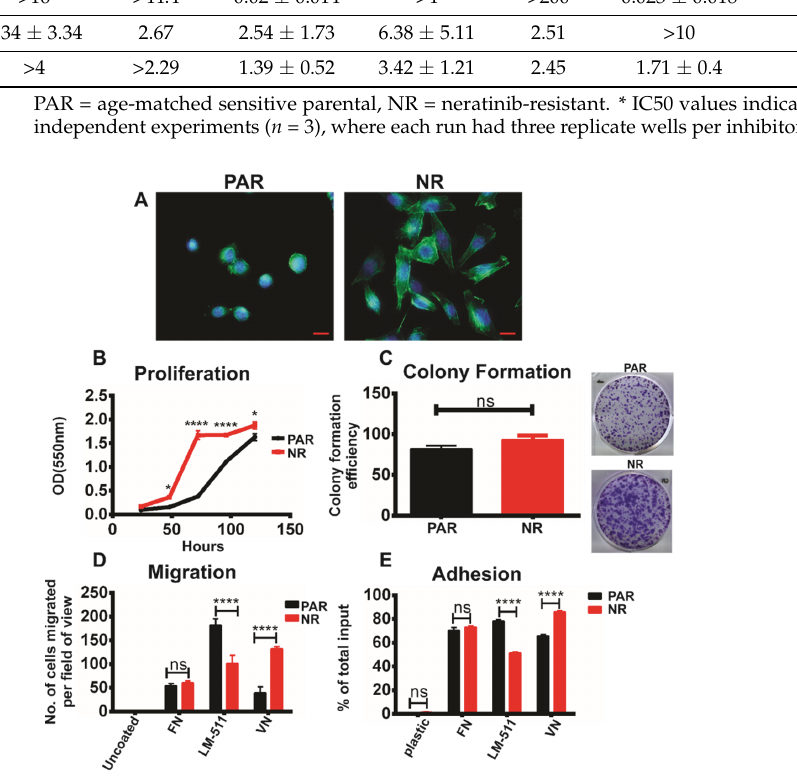
Figure 1. Morphological and functional characterisation of TKI-resistant cells in vitro. ( A ) The alterations in morphology and actin cytoskeleton were visualised in the resistant TBCP-1NR cells (NR) and compared to age-matched sensitive TBCP-1 cells (PAR) by F-actin staining using A488-conju- gated phalloidin. Red (Scale bar) = 50 µm. Blue (DAPI) = nuclei. Green (A488-phalloidin) = F-actin. ( B ) Cell proliferation was measured in TBCP-1 (PAR) or TBCP-1NR (NR) cells using a sulforhoda- mine B (SRB) colourimetric assay. Cells were seeded at 1000 cells/well in triplicates in 96-well plates and cultured over 5 days. Cell proliferation was measured at the indicated time points. Each point on the curve represents the mean ± SD of triplicates of the respective time point from a representa- tive experiment of three independent experiments ( n = 3). Statistical significance was determined using two-way ANOVA, Bonferroni’s multiple comparison test; p < 0.05 was considered significant, * p < 0.05, **** p < 0.0001. ( C ) Colony formation was measured in TBCP-1 (PAR) or TBCP-1NR (NR) cells over 10 days. Cells were seeded at 500 cells/well in a 6-well plate in triplicates and colonies were fixed with methanol and stained with crystal violet. Data show mean colony-formation effi- ciency (no. of colonies formed/total no. of cells plated × 100) ± SD of triplicates from a representative experiment of three independent experiments ( n = 3). Statistical significance was determined using the Mann–Whitney t -test; p < 0.05 was considered significant, ns = not significant. ( D ) Haptotactic migration of TBCP-1 (PAR) or TBCP-1NR (NR) cells in response to the indicated ECM proteins was evaluated in Transwell chambers and the number of migrating cells per field of view was deter- mined manually by counting DAPI-positive cells on the underside of the porous membrane. The data show mean ± SD of nine replicates (3 fields of view per membrane × triplicate membranes per condition) from a representative experiment of three independent experiments ( n = 3). ( E ) The ability of TBCP-1 (PAR) or TBCP-1NR (NR) cells to adhere to the indicated ECM proteins was determined in a short-term (30 min) assay and data are shown as mean ± SD of triplicates from a representative experiment of three independent ( n = 3) experiments. Statistical significance for migration and ad- hesion assays was determined using two-way ANOVA, Tukey’s multiple comparison test; p < 0.05 was considered significant, **** p < 0.0001, ns = not significant. VN = vitronectin, LM-511 = laminin- 511, and FN = fibronectin.